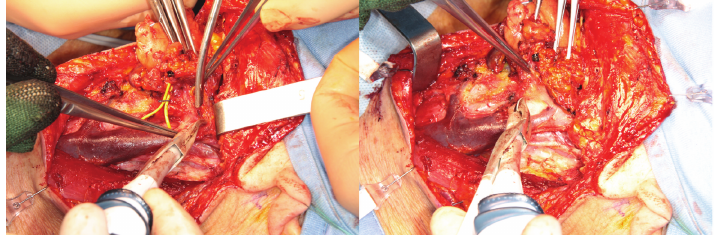
Figure3:NeckdissectionofII-IIIlevelwithFocusUltracisionharmonicscalpel:planeoftheinternaljugularveinwithsealingofthetributary vessels.